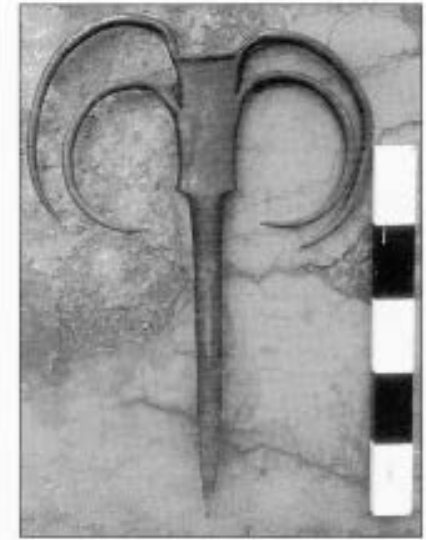
Figure 6 Ceremonial iron anvil with embossed horns from the Karagwe regalia (scale bar intervals